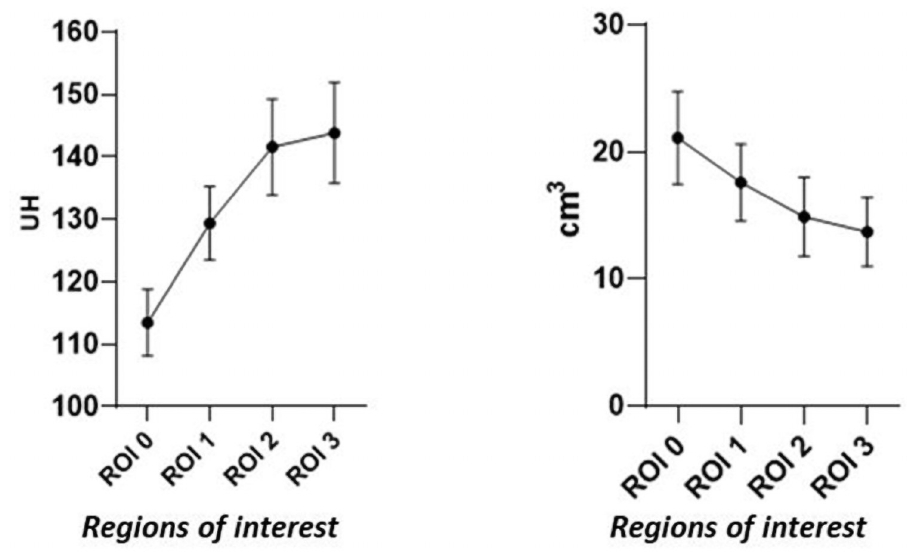
Fig 4. Hepatic average volume for all rats and the average attenuation